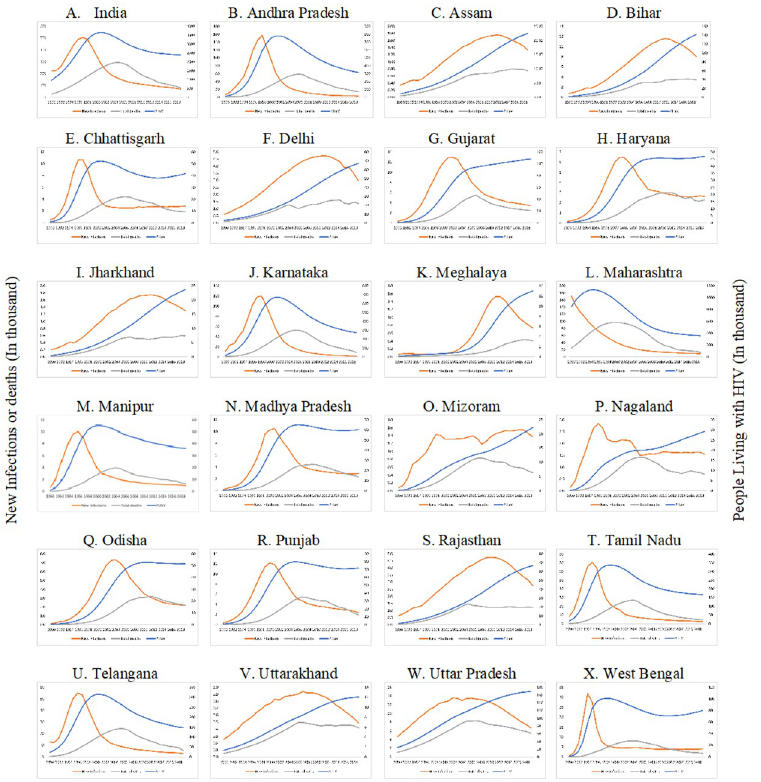
Fig 1. Annual new HIV infections, annual all-cause mortality among PLHIV and total number of PLHIV by select States in India, 1990–2019. The years (1990–2019) are reflected on X-axis; number of new infections (in 1000s) and total deaths and PLHIV (in 1000s) are on primary Y-axis while total number of PLHIV (in 1000s) is on secondary Y- axis. Orange line depicts new infections, grey line depicts total deaths among PLHIV, and blue line represents total PLHIV